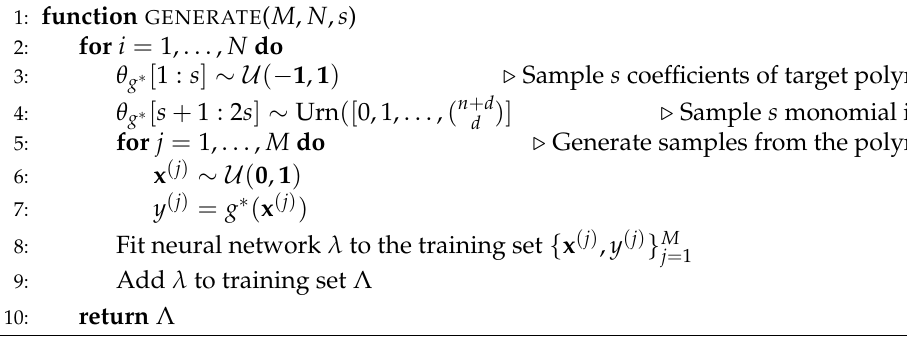
Algorithm 1 Generate training data for I -Net of sparse polynomials (here, U ( 0 , 1 ) denotes independent samples from a continuous, uniform distribution over the interval [ 0, 1 ]